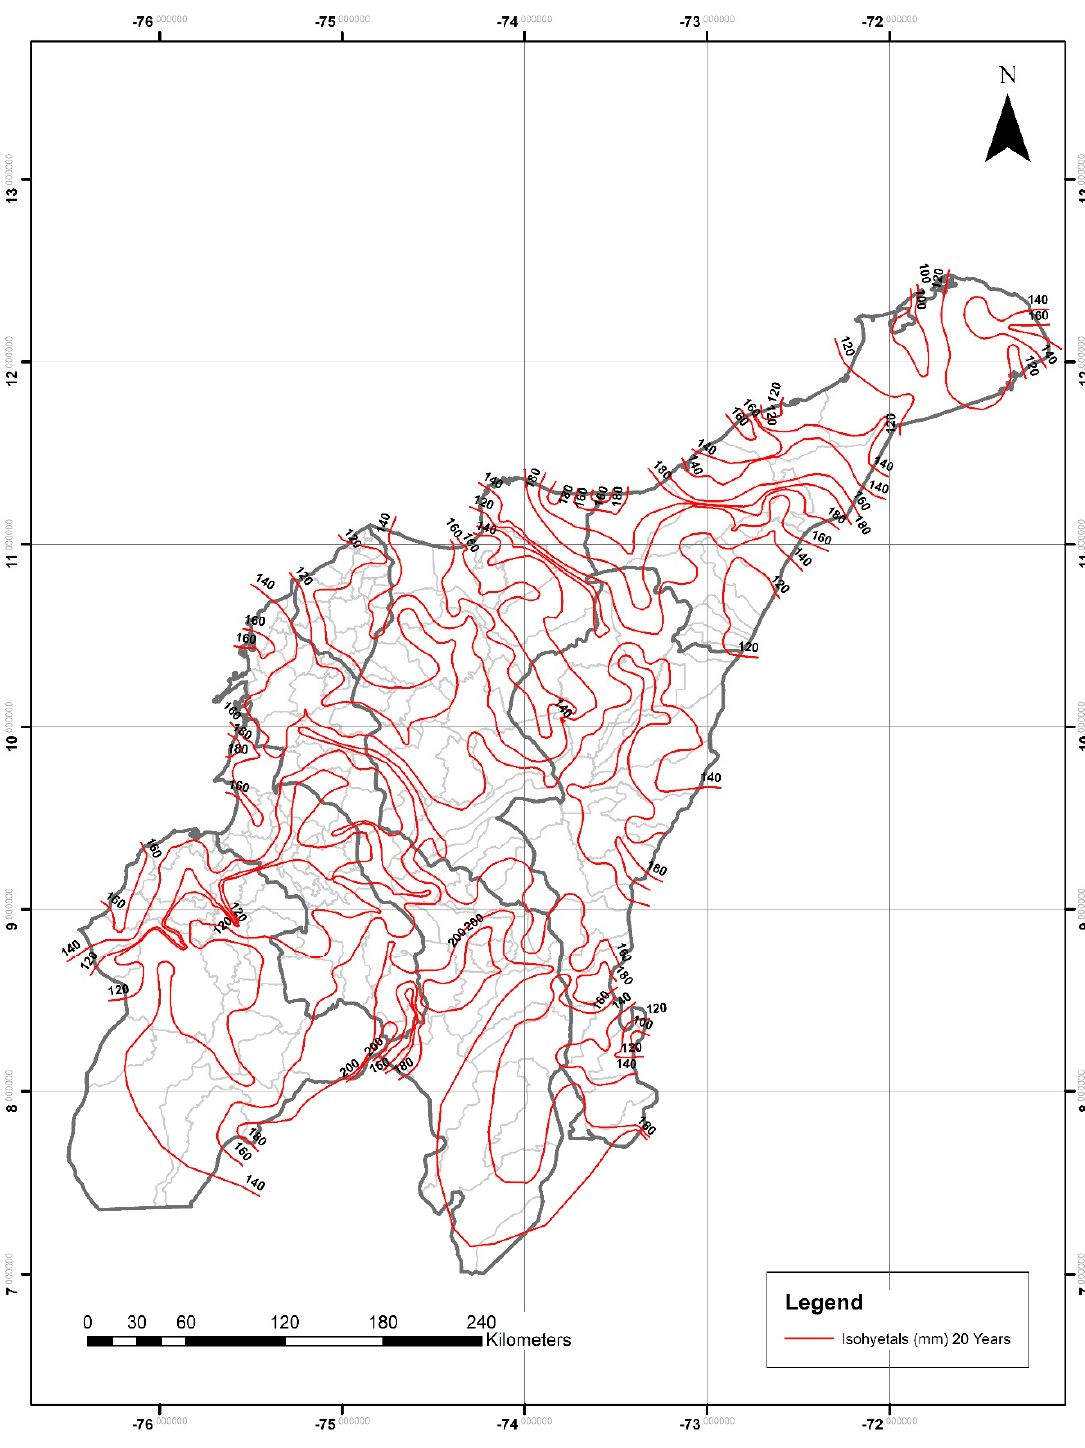
Figure 9. Daily maximum precipitation for a 20-year return period (P 24h-max in mm). IDW adjusted method. Light-gray lines are the boundaries of the different municipalities within the departments.